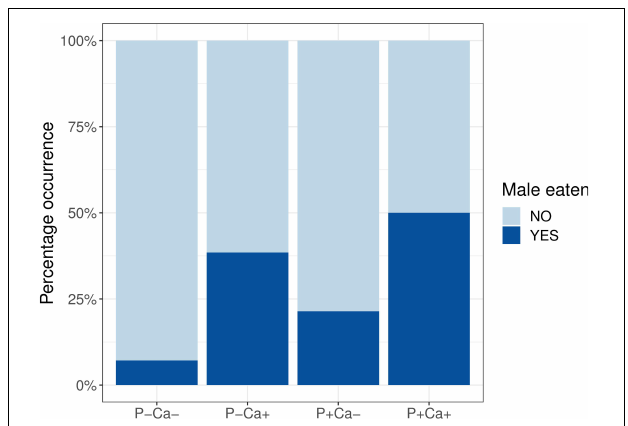
FIGURE 2 | Bar plot showing percentage occurrence of cannibalism by female crickets at the initial phase of the experiment for each food treatment combination. P+/P–: P treatment contrasts; Ca+/Ca–: lime treatment contrasts.